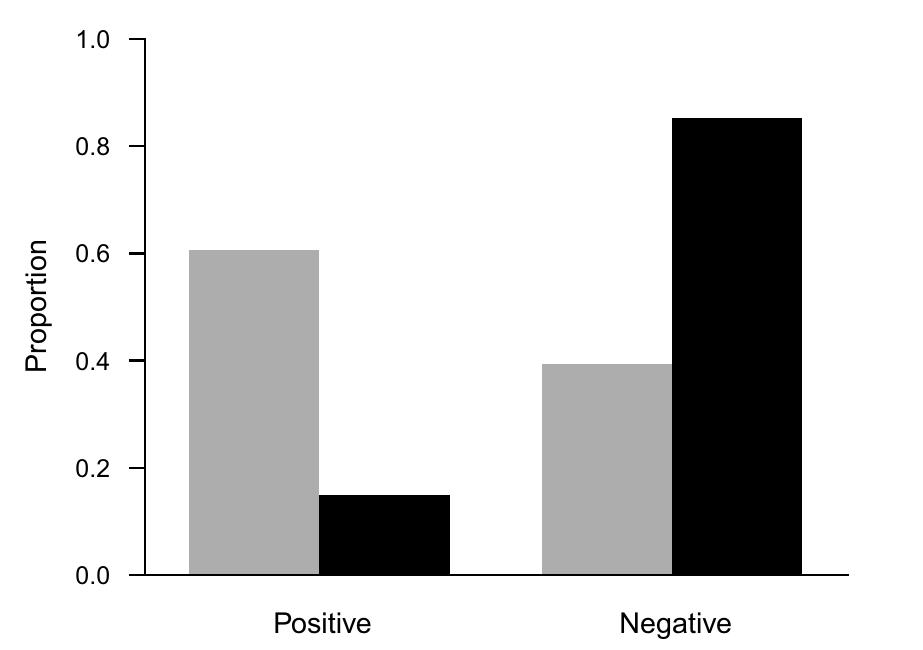
Fig 5. Proportion of the labels. Gray bars are observed proportions when participants labeled positive (threat) and negative (no threat). Black bars are the proportion of true answers when participants opted for “I don’t know”.